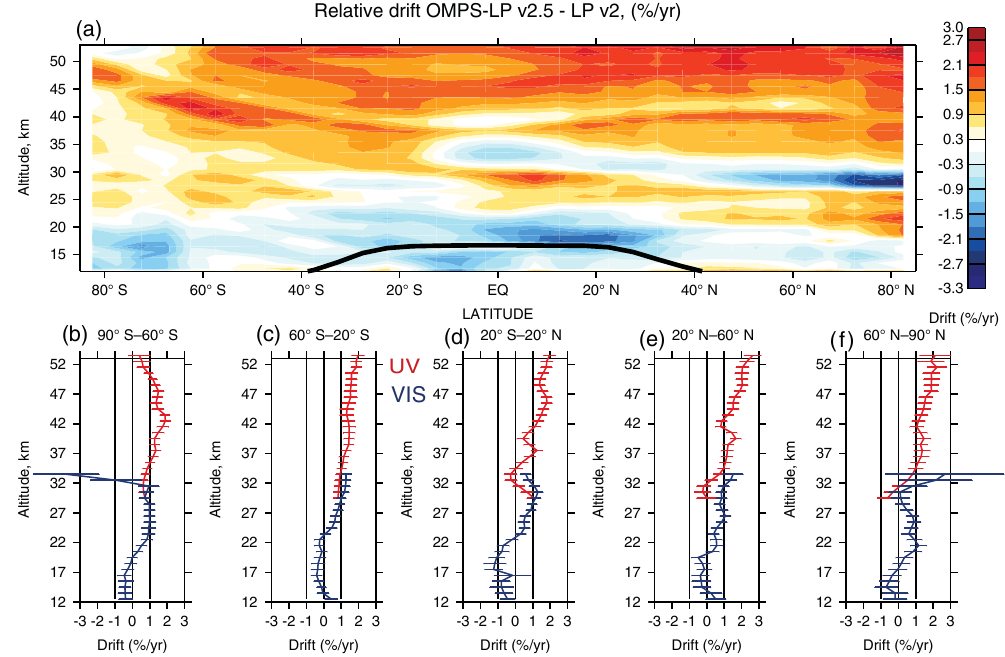
Figure 6. Relative drift between OMPS LP version 2.5 and OMPS LP version 2. Panel (a) shows the drift as a function of latitude and height (on 5 ◦ latitude grid). Panels (b–f) show vertical structures of the drift in five wide latitude bins. Horizontal error bars show 1 σ errors for the linear fit. Red lines indicate drifts for the UV ozone retrievals and blue lines for VIS.